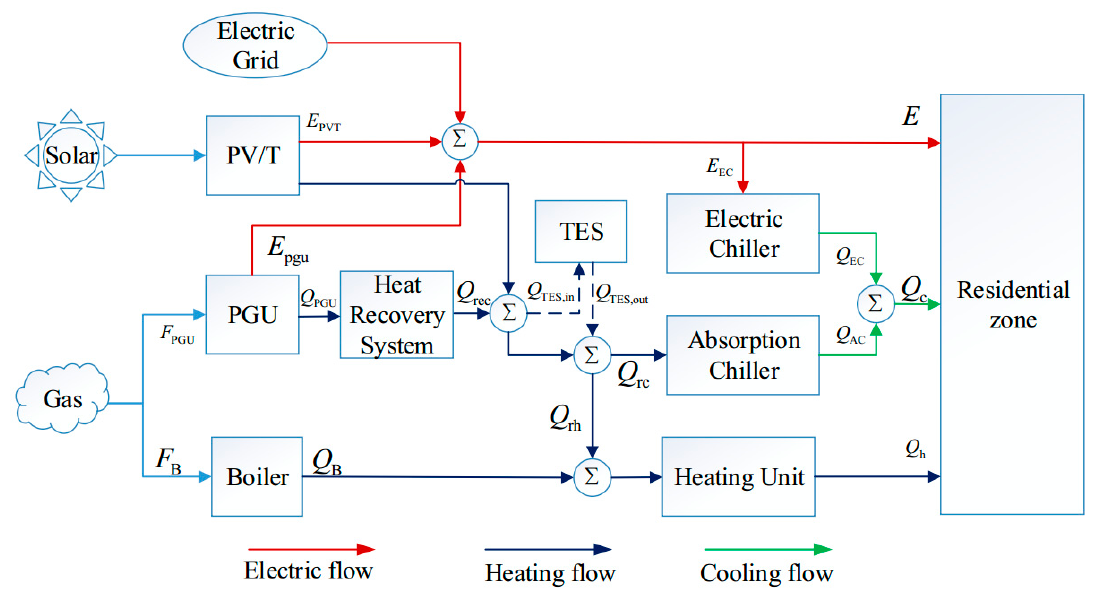
Figure 1. Scheme of combined cooling, heating and power (CCHP) system and its energy flow.